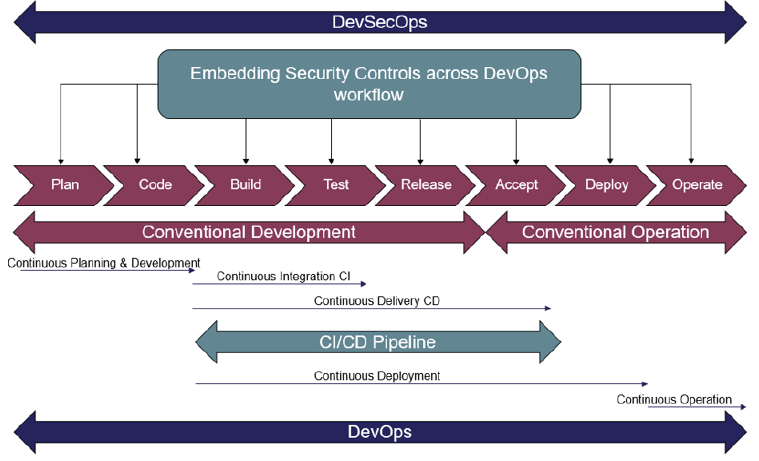
Figure 8. ASSIST-IoT DevSecOps